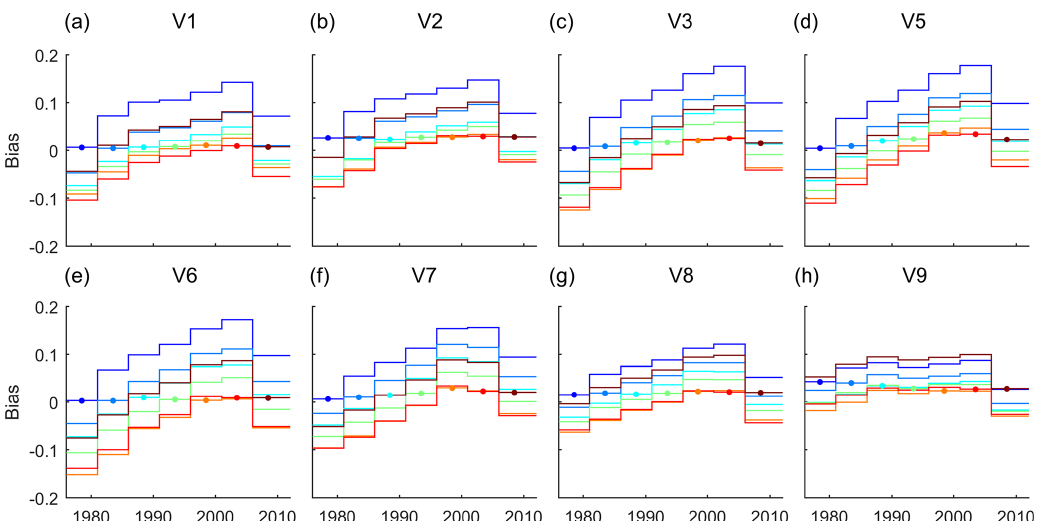
Figure 5. Bias for the different subperiods averaged over all study catchments for model variants V 1– V 3 and V 5– V 9 (model variant V 4 was not calibrated for different subperiods). Figure 3a shows this for the baseline model V 0. Each line refers to models calibrated in one subperiod, where the filled circle marks the calibration period, and shows bias during the calibration period and during evaluation in the other six subperiods. For a description of the model variants, see Table 3 and Sect.